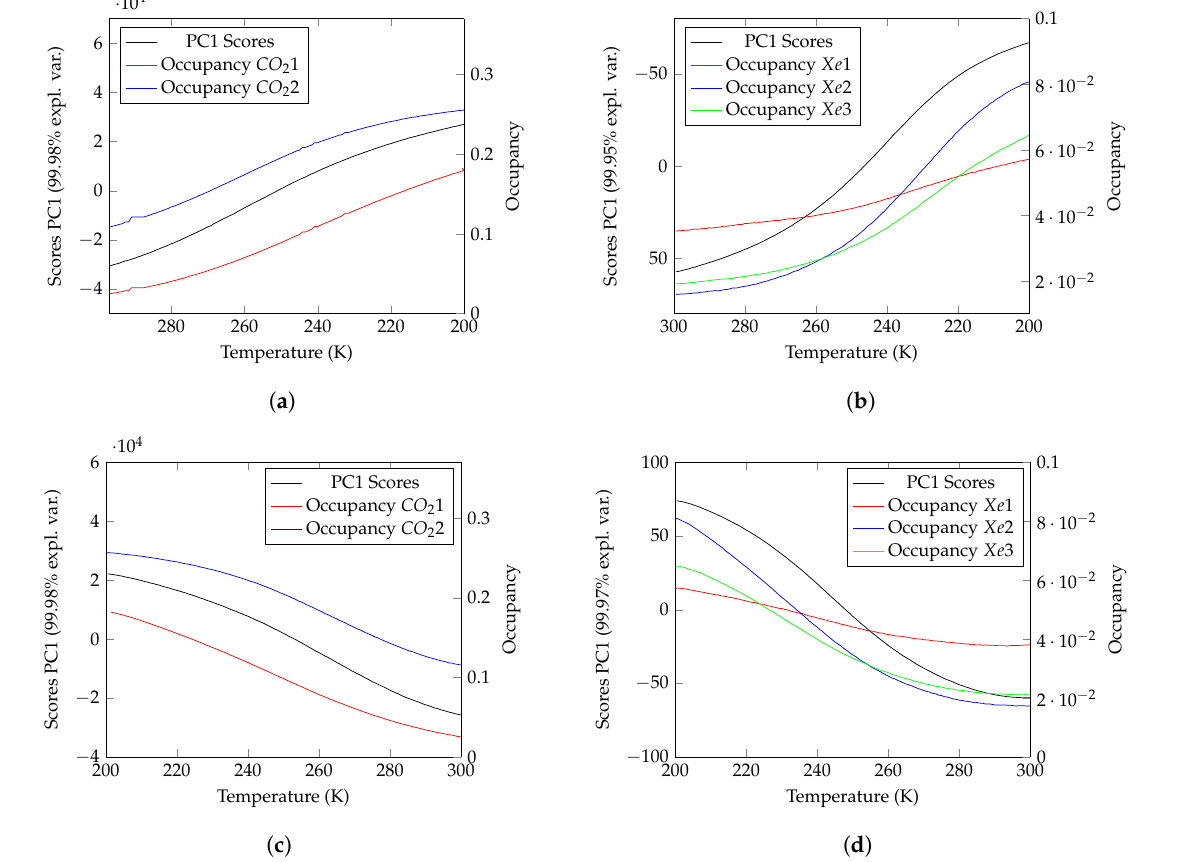
Figure 6. Superposition of PC1 scores with CO 2 ( left ) and Xe ( right ) occupancy during ramp down ( top ) and up ( bottom ). ( a ) PC1 scores vs. CO 2 occupancy. ( b ) PC1 scores vs. Xe occupancy. ( c ) PC1 scores vs. CO 2 occupancy. ( d ) PC1 scores vs. Xe occupancy.